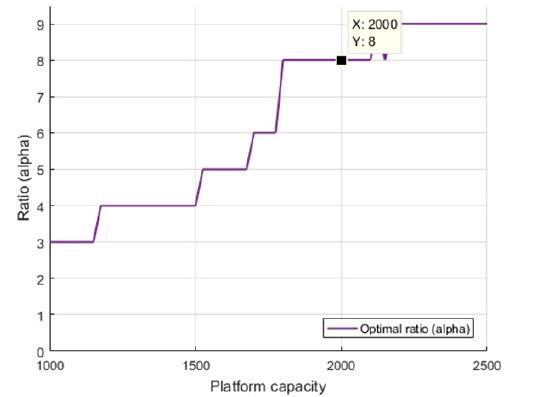
Figure 3. The attraction factor relation with the club capacity.